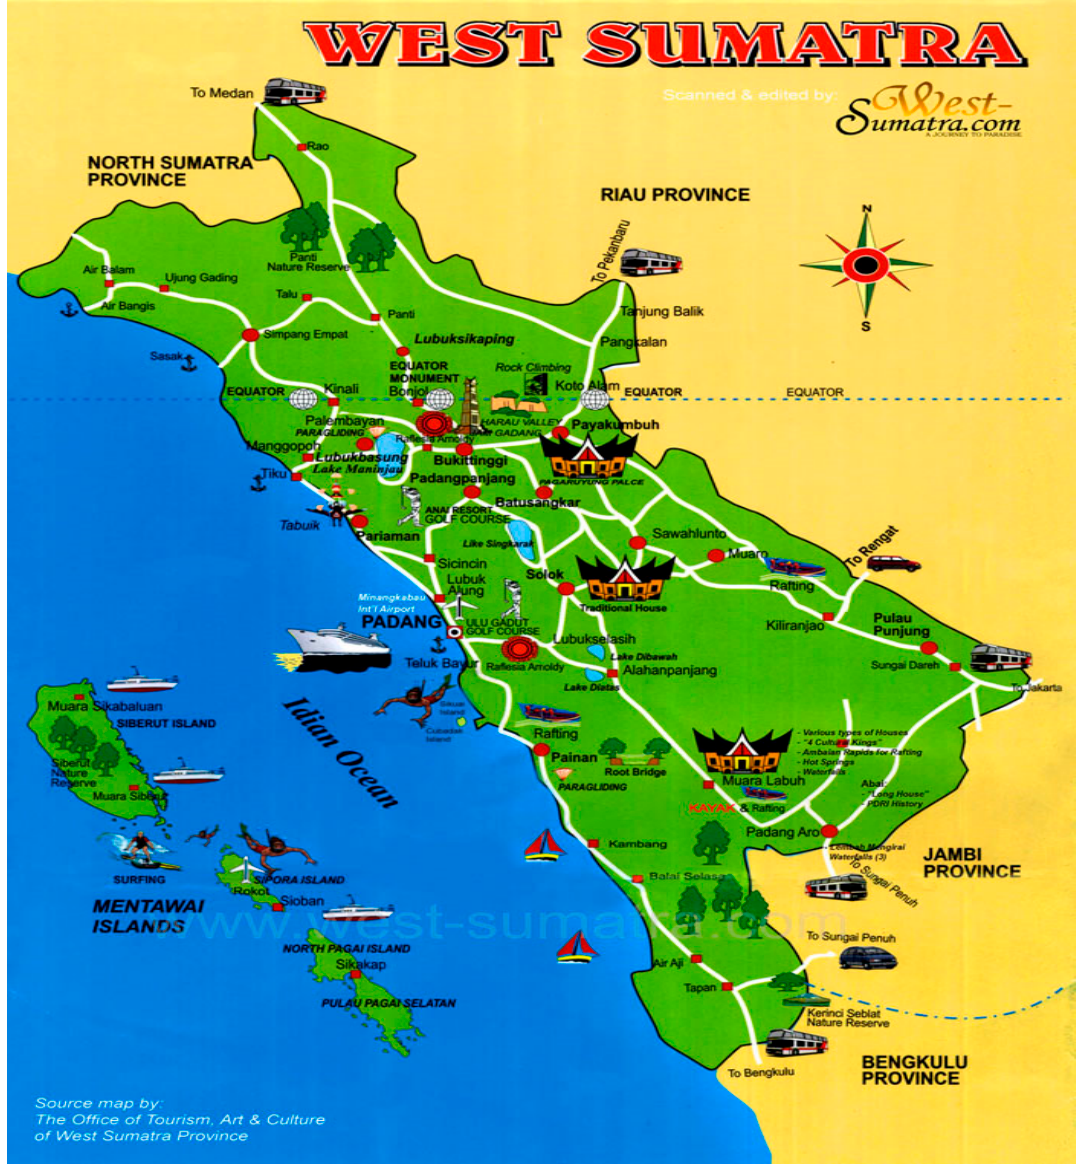
Figure 1. Map of the Research Areas.